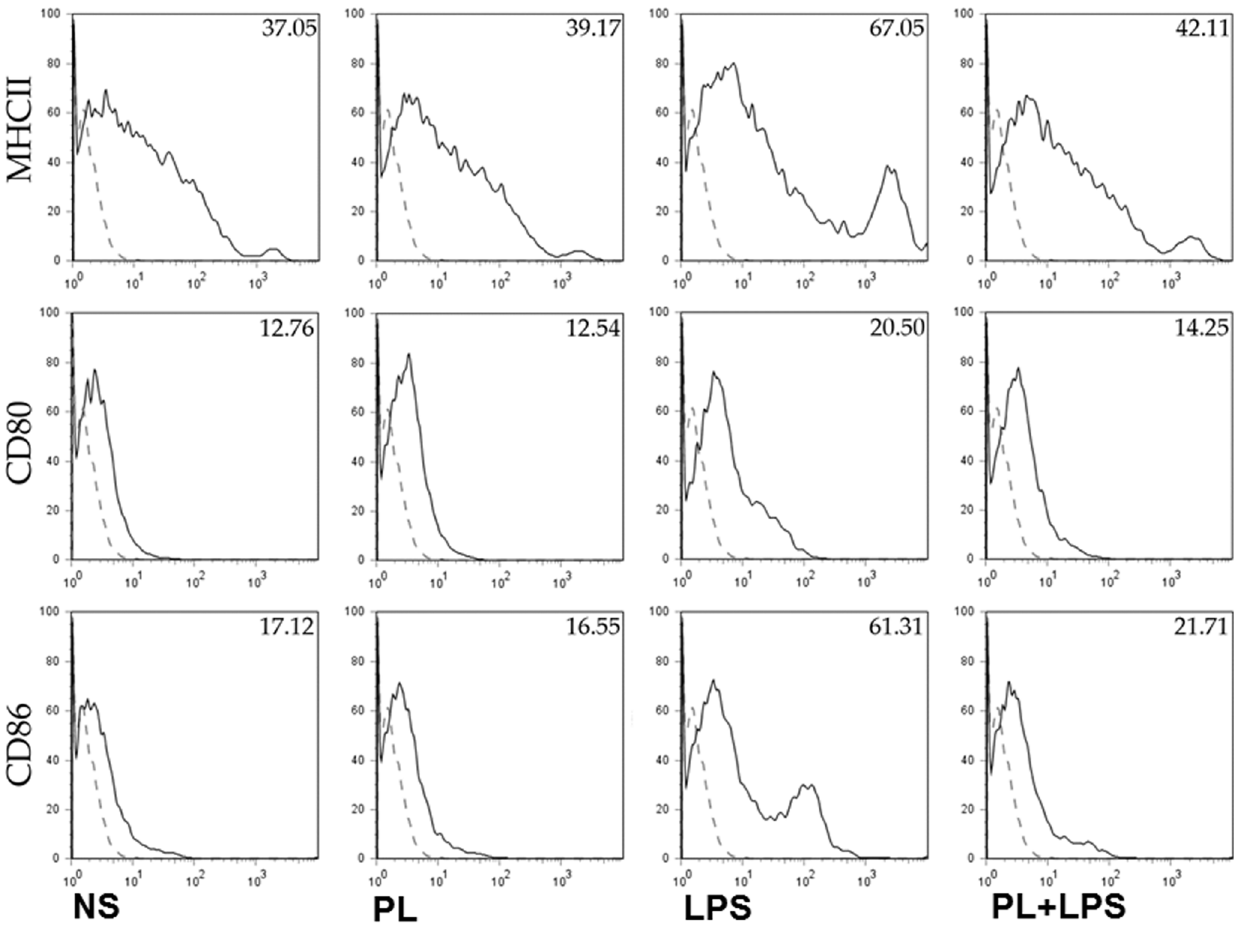
Figure 2. Helminth antigens downregulated surface maturation markers on BMDMs. BMDMs were pulsed with medium alone, PL at 25 ug/ml, LPS at 10 ng/ml, or PL at 25 ug/ml twenty min prior to the addition of LPS to a final concentration of 10 ng/ml in the medium (PL + LPS) and cultured for a total of 20–24 h period. BMDMs were harvested and FACS analysis was performed to measure surface expression of MHC-II, CD80, and CD86. Dotted line in the histogram shows control staining with isotype/fluorochrome control Ab, and filled line shows signal with specific Ab.